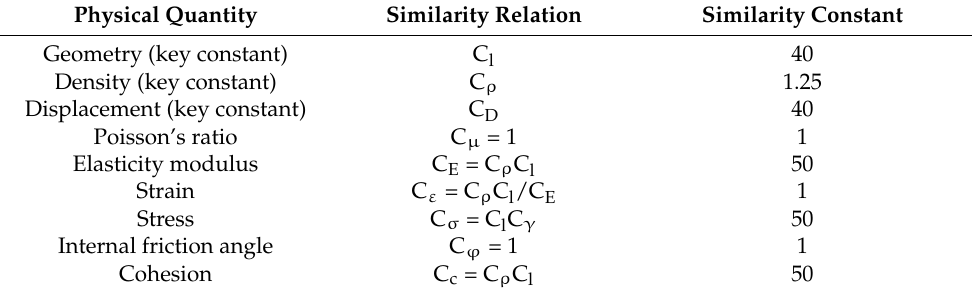
Table 2. Similarity